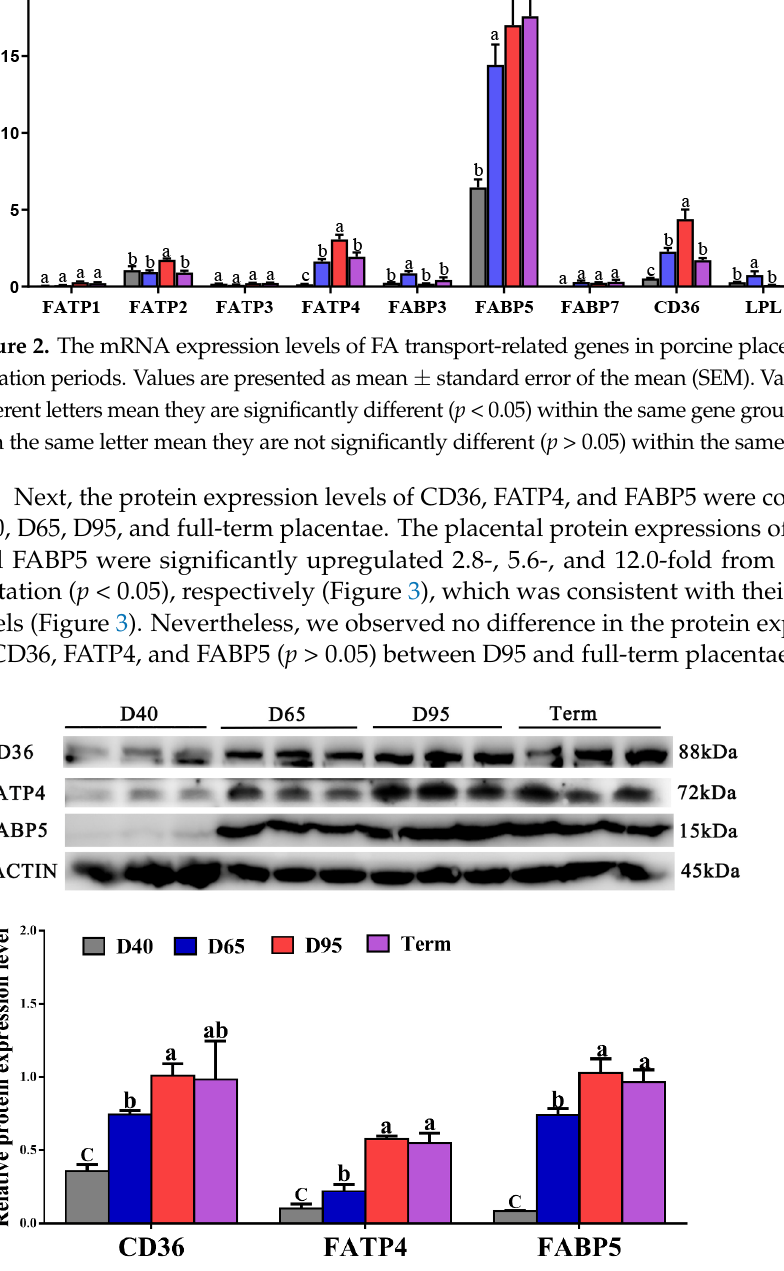
Figure 3. Comparison of protein expression levels of FA transport-related proteins in porcine placentae on D40, D65, D95, and term gestation. ( A ) Western blot analyses of protein expression levels and endogenous control β-actin. ( B ) Relative quantification of protein expression levels. Values are presented as mean ± SEM. Values labeled with different letters mean they are significantly different ( p < 0.05) within the same gene group. Values labeled with the same letter mean they are not significantly different ( p > 0.05) within the same protein group.